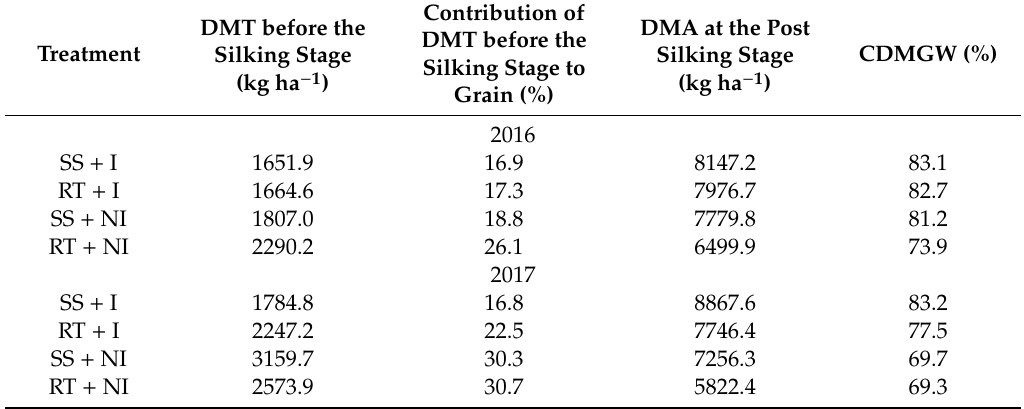
Figure 4. Aboveground dry matter accumulation (DMA)of different soil tillage practices. Different letters above the bars indicate significant differences between tillage practices. Table 6. Dry matter translocation (DMT) from vegetative organs to grain and accumulation amount at the post silking stage.